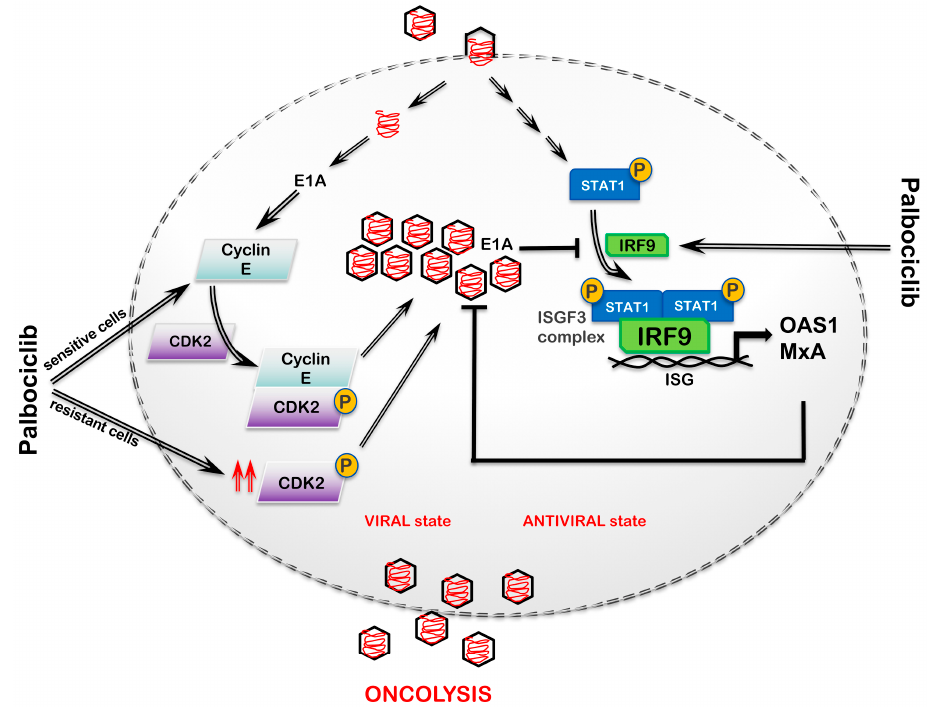
Figure 8. Model of interaction between an oncolytic virus and the host type I IFN response and cyclin expression. Host pattern recognition receptors (PRR) will recognize intracellular viral particles